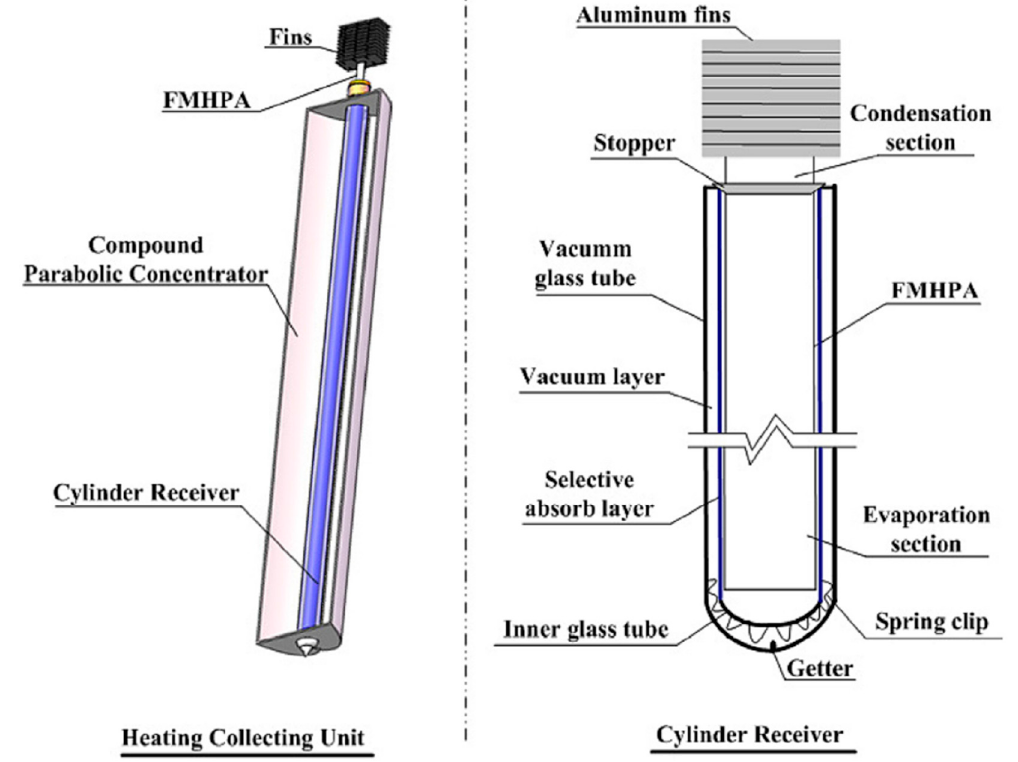
Figure 19. Schematic of the CPC with flat micro-heat pipe arrays (FMHPA) (left: Heating collecting unit; right: Cylinder receiver) [41].